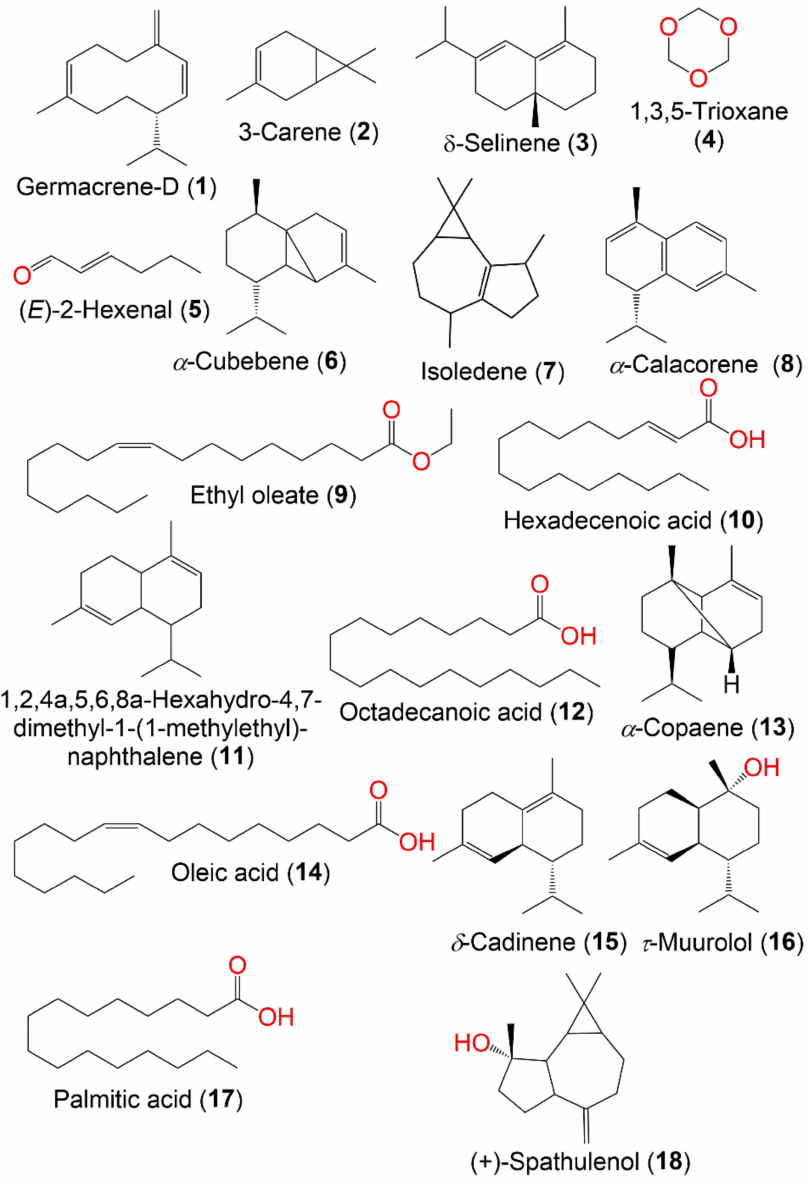
Figure 1. Structures of compounds 1 – 18 from Lansium domesticum . The organic acids and their concentration in langsat and duku fruits were assessed using reversed-phase HPLC technique. The results revealed that the total organic acids in duku and langsat fruits were 0.604 and 1.04%, respectively, where citric ( 19 ) and malic acids ( 20 ) represented the major acids found in both fruits. Whilst piroglutamic ( 21 ) and ascorbic ( 22 ) acids existed in low concentrations [36]. Moreover, citric acid ( 19 ), glycolic acid ( 23 ), maleic acid ( 24 ), and malic acid ( 20 ) are the predominant acids found in the fruit (Figure 2)